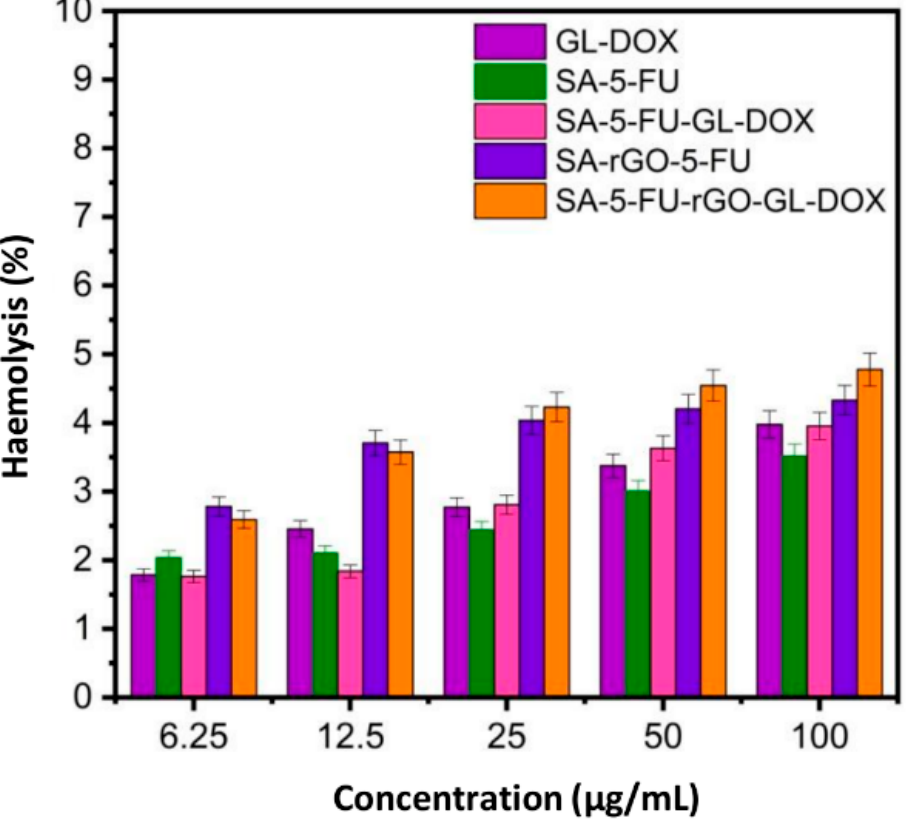
Figure 7. Percentages of erythrocytes lysed upon treatment with different beads (GL-DOX,